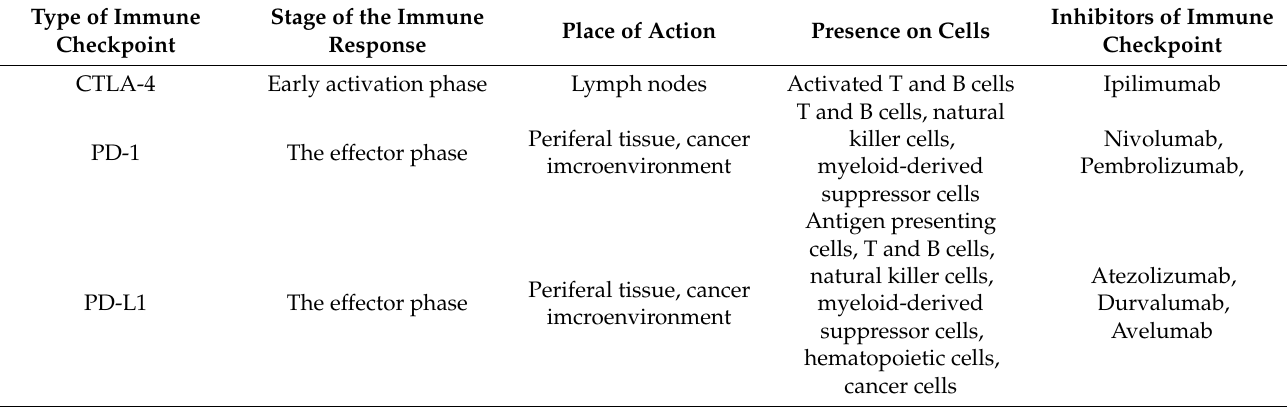
Table 1. Immune checkpoints and their inhibitors. CTLA-4—Cytotoxic T-Lymphocyte-associated Antigen 4, PD-1— Programmed Death 1, PD-L1—Programmed Death-Ligand